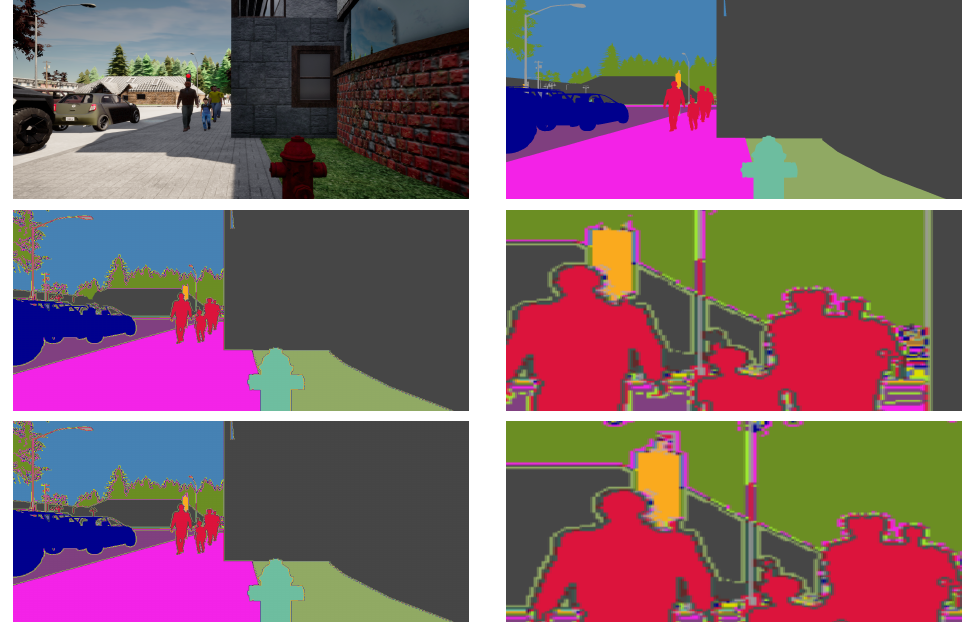
Figure 4. Qualitative evaluation, scenario 1. From the top down, the first row shows a sample snippet (sidewalk, traffic light, and pedestrians at far) with its ground-truth annotation. The second and third row contains the segmentation prediction maps with a zoom-in for detail depiction, from GSVNET SN-R18 and our SN-R18